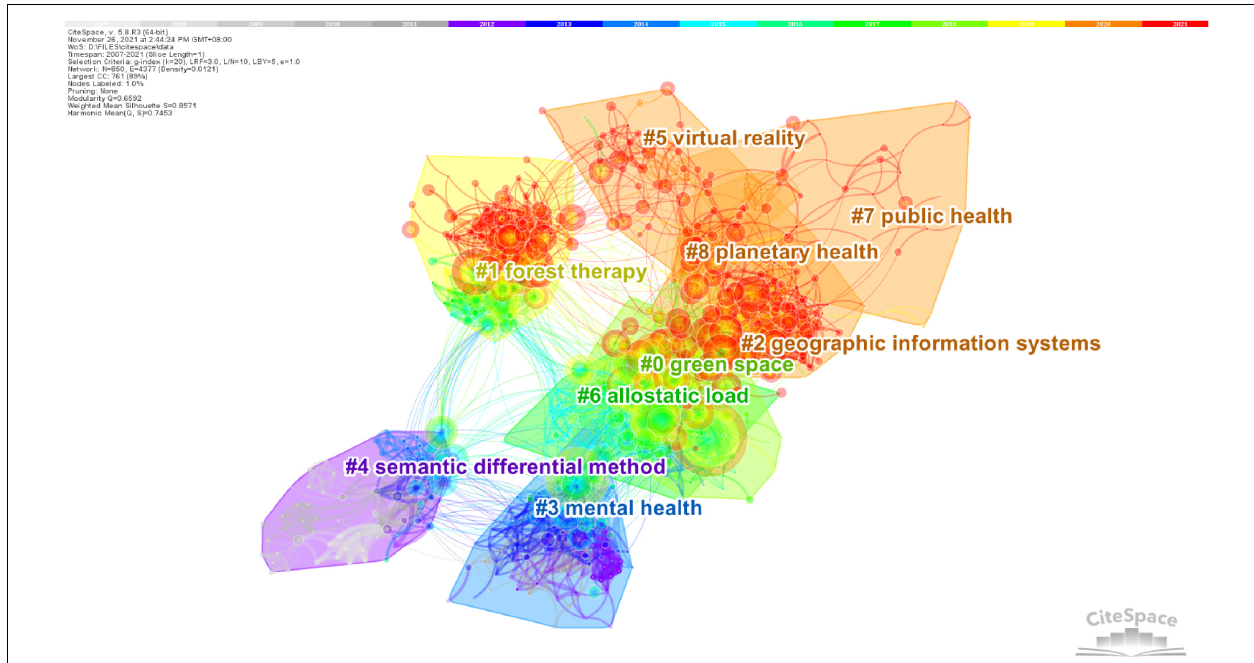
FIGURE 6 | A landscape view of the main clusters.